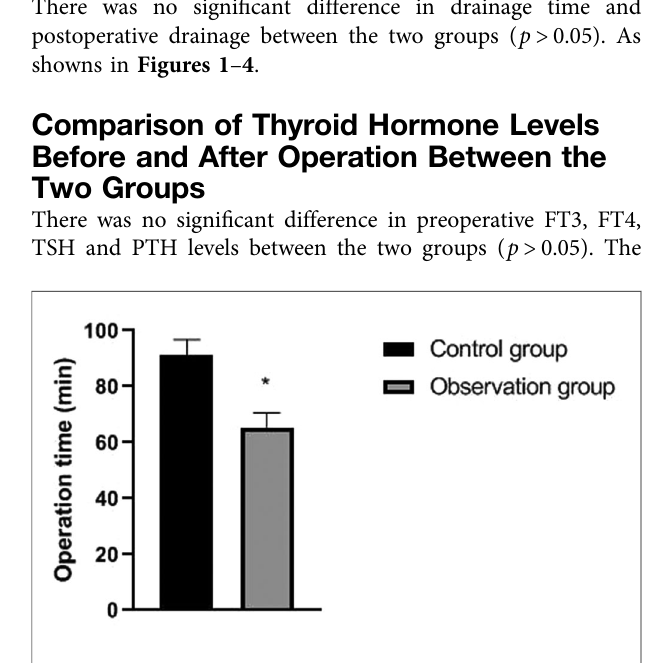
FIGURE 1 | Comparison of operation time between the two groups. Note: compared with the control group, * p <0.05.